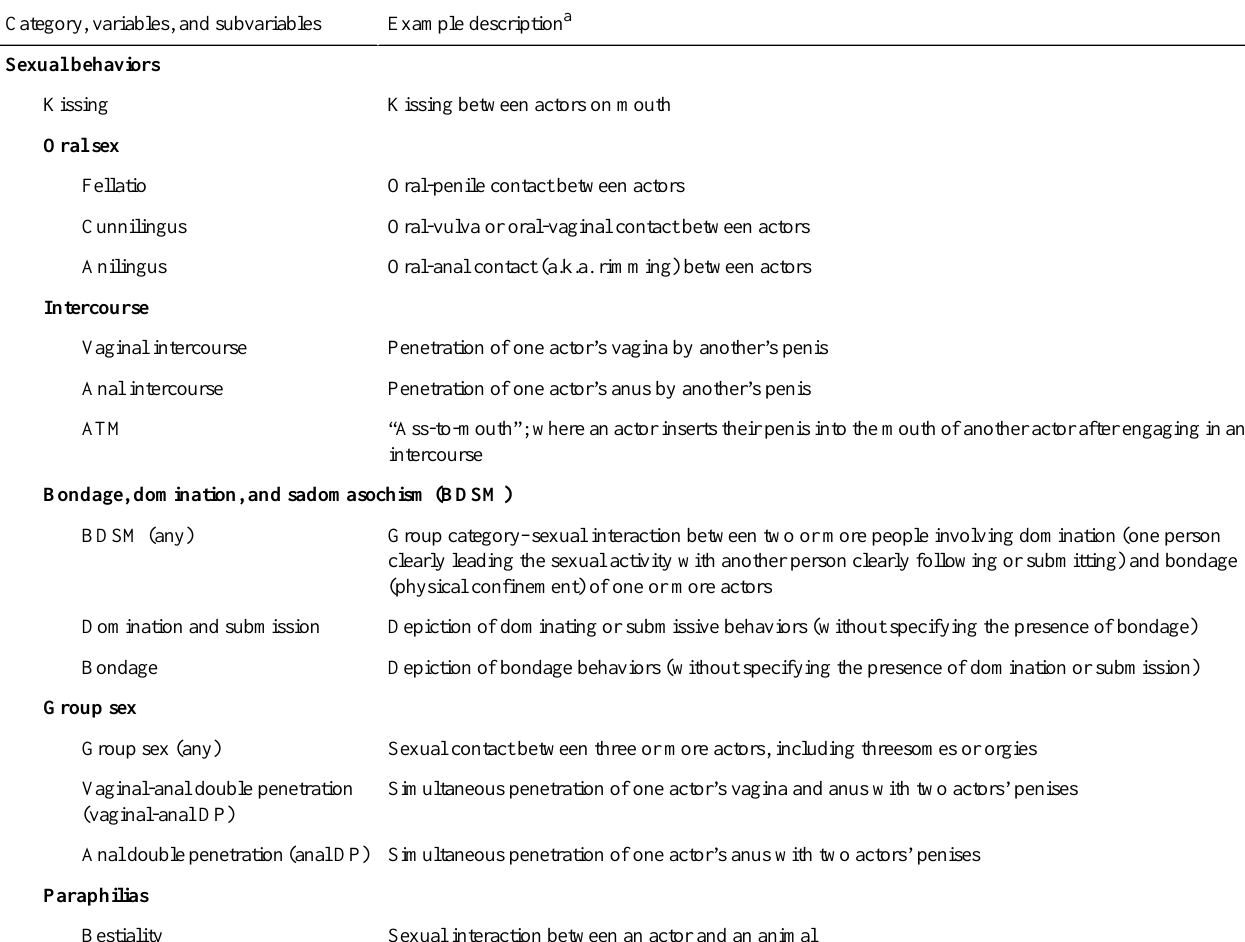
Table 1. Variables included in the systematic review. Sexual